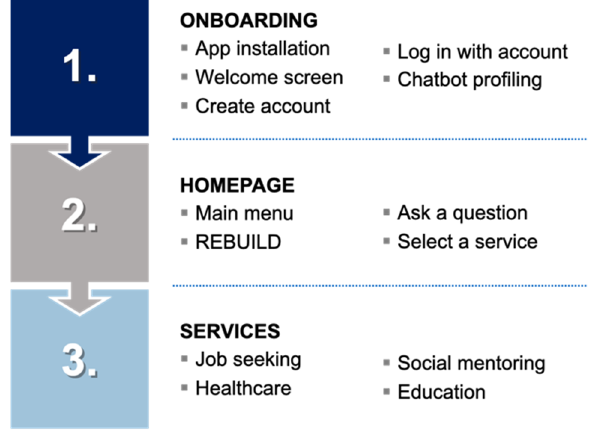
Figure 2. Sequence of App testing scenarios for all testing groups.